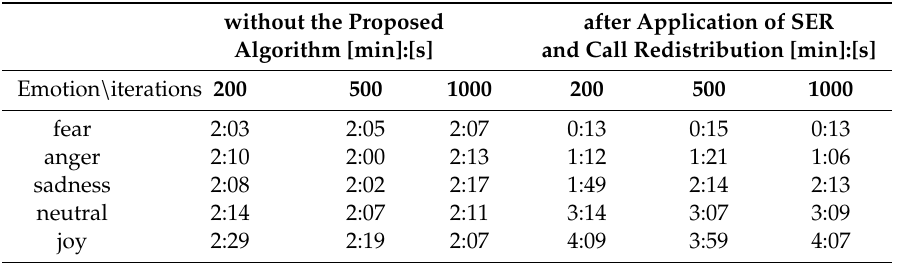
Table 6. Average waiting time when 3 calls are received simultaneously while all operators are busy.